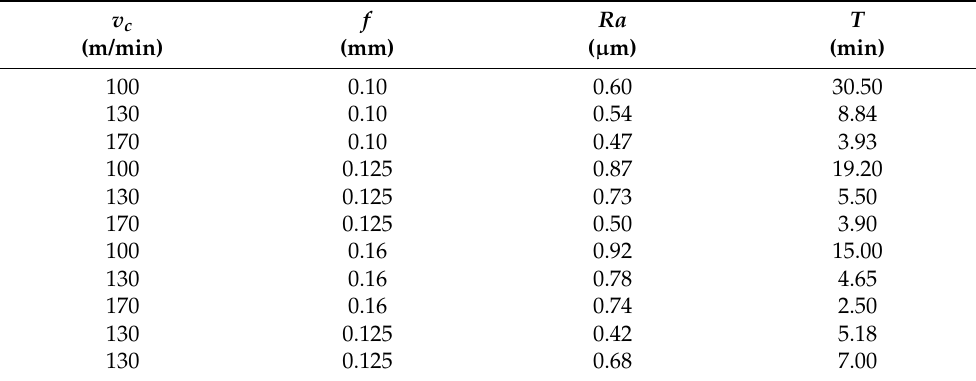
Table 2. Experimental results for surface roughness and tool life. (Note: v c is cutting speed, f feed, Ra surface roughness, and T tool life).